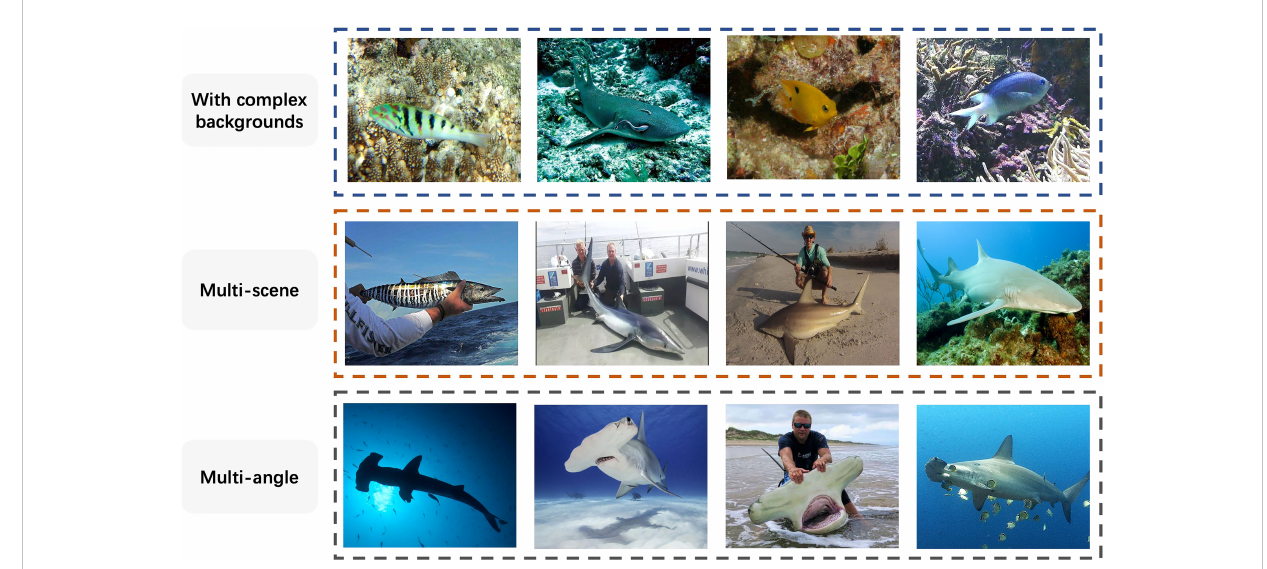
FIGURE 1 Some examples of marine life images. Three rows sequentially represent images with complex backgrounds, images of multiple scenes, and images of marine life taken from multiple